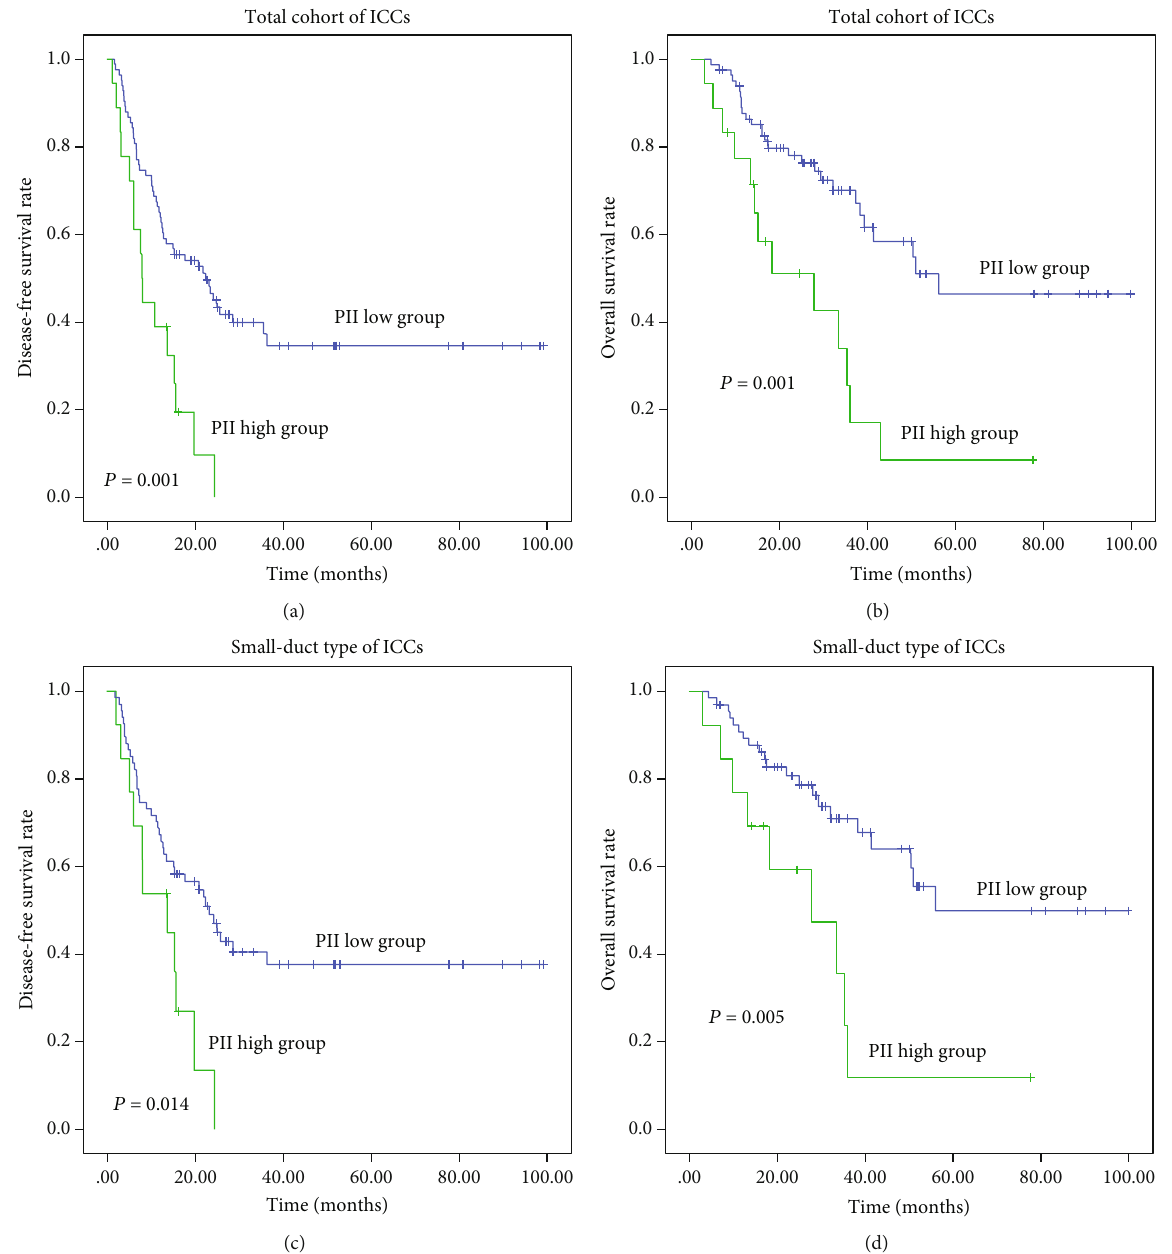
Figure 1: Survival analysis showing patients with high PII had poor prognosis in ICCs (a) and (b) and their small-duct type (c) and